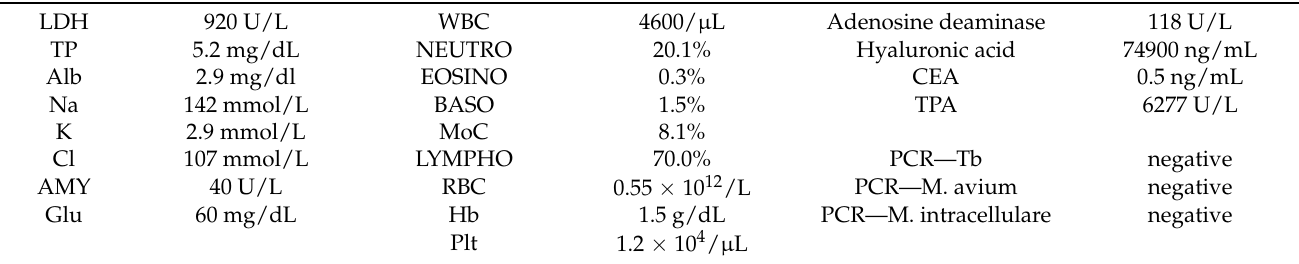
Table 2. Laboratory data at the onset of cardiac